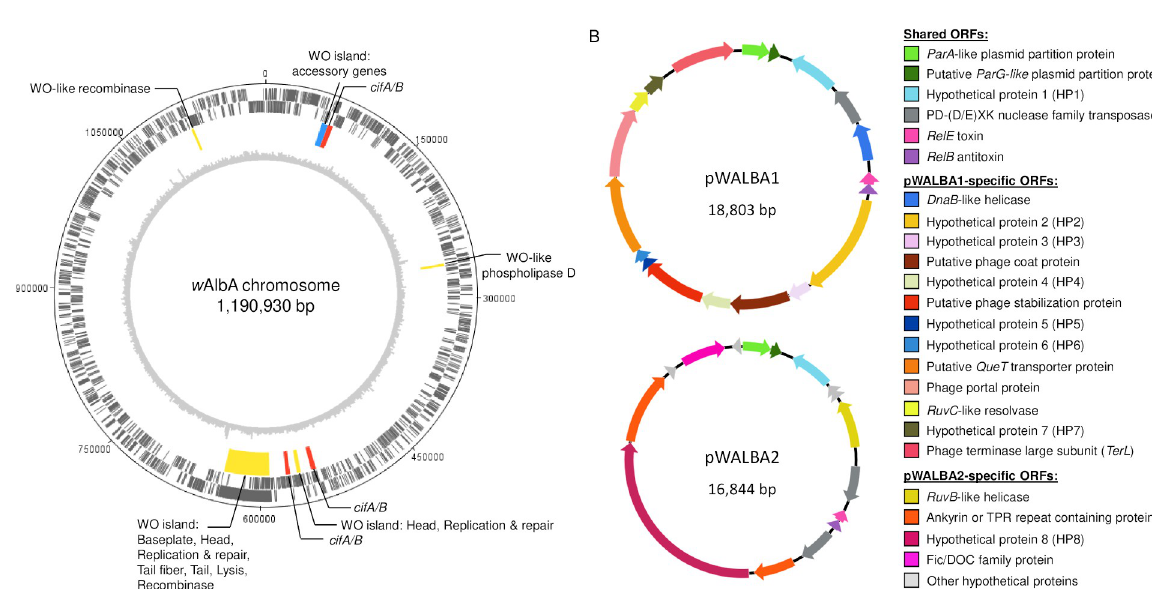
PLOS Genetics | https://doi.org/10.1371/journal.pgen.1010406 September 19,